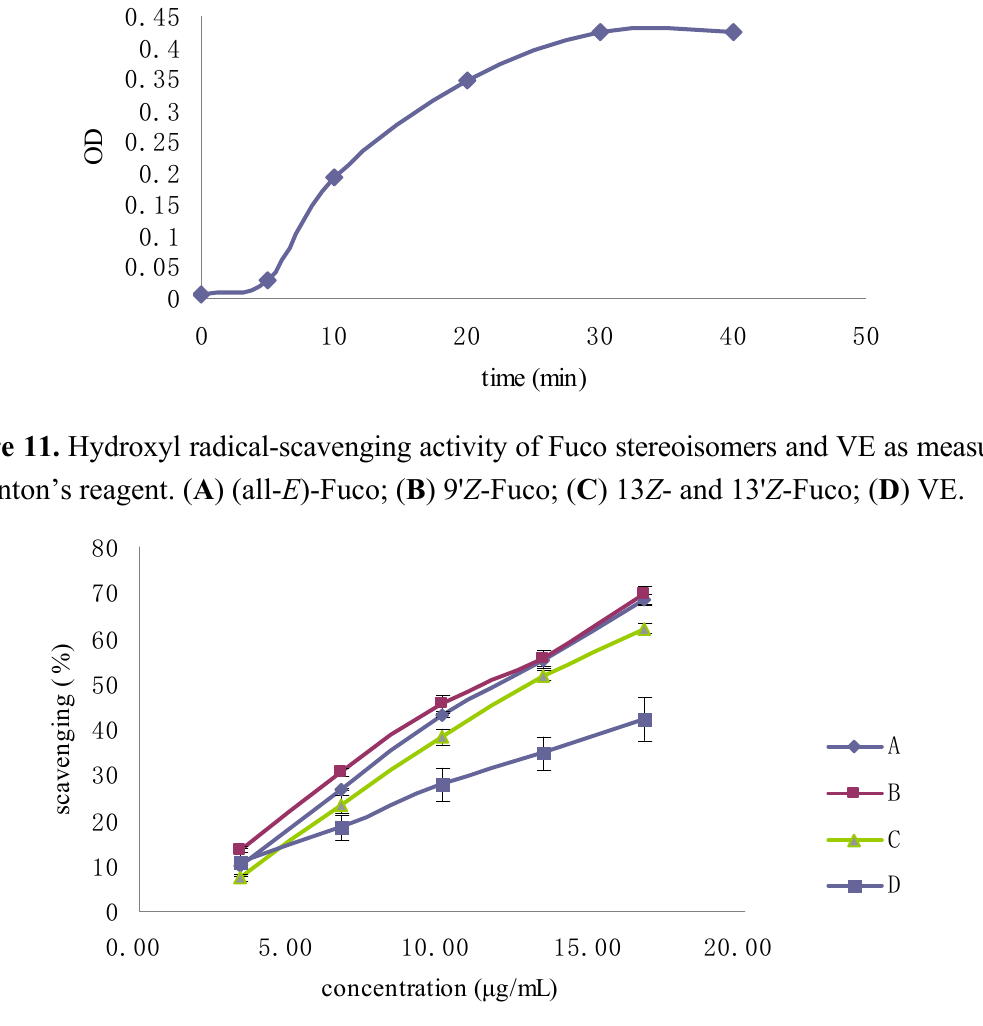
Figure 10. Relationship between absorbance and time for hydroxyl radical generation by Fenton’s reagent at 37 °C.